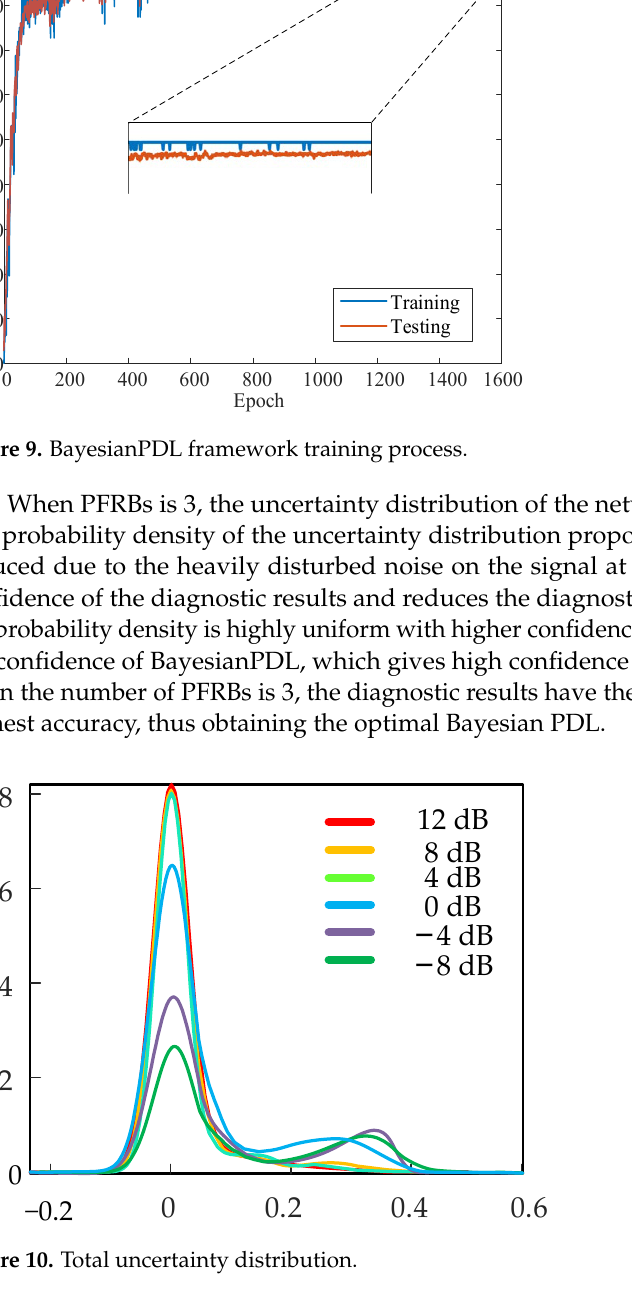
(ROC) curves of different fault labels are as shown in Figure 11. As a result, the BayesianPDL identified by the BayesianPDL framework. The input time–frequency feature map as shown in Figure 12a, and the features identified map by the BayesianPDL framework as shown in Figure 12b. The fault features of the outer ring are represented by feature (1) and feature (2), respectively, and the feature (2) is not obvious. However, the BayesianPDL framework can effectively identify fault features, such as feature (3) and feature (4), during the diagnostic process. This demonstrates that the proposed method has a strong feature extraction ability in the process of wind turbine bearing